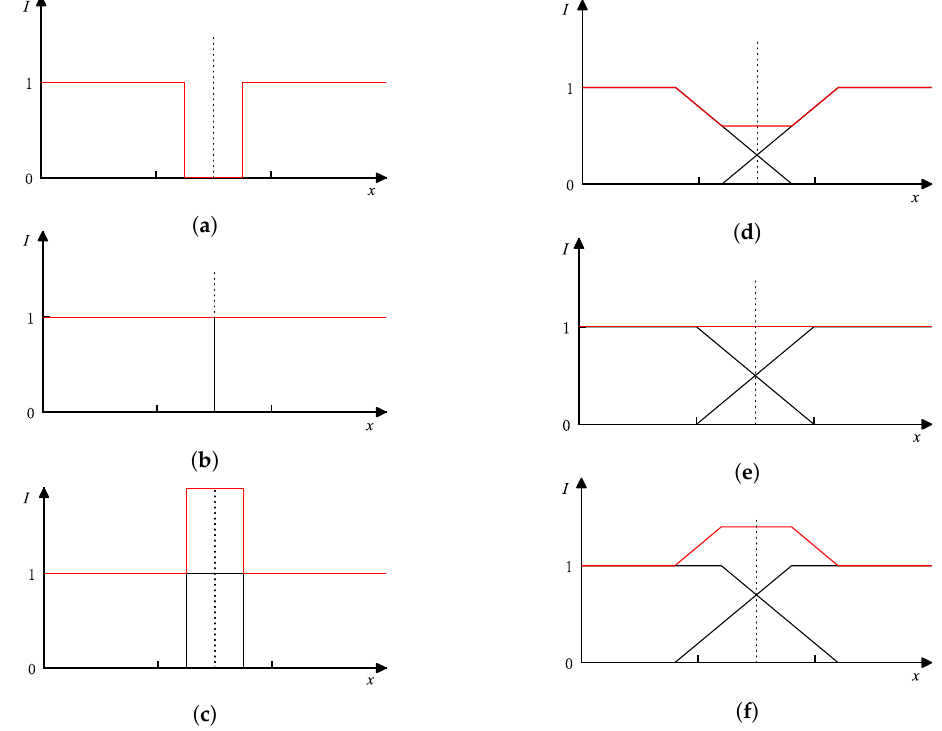
Figure 5. Comparisons of normal and filtered elemental hologram tiling. Horizontal axis represents x and vertical axis represents intensity of reconstructed image. Black lines show intensity of each elemental hologram and red lines show the total intensity. ( a ) Gap with normal edge; ( b ) Aligned with normal edge; ( c ) Overlap with normal edge; ( d ) Gap with filtered edge; ( e ) Aligned with filtered edge; ( f ) Overlap with filtered